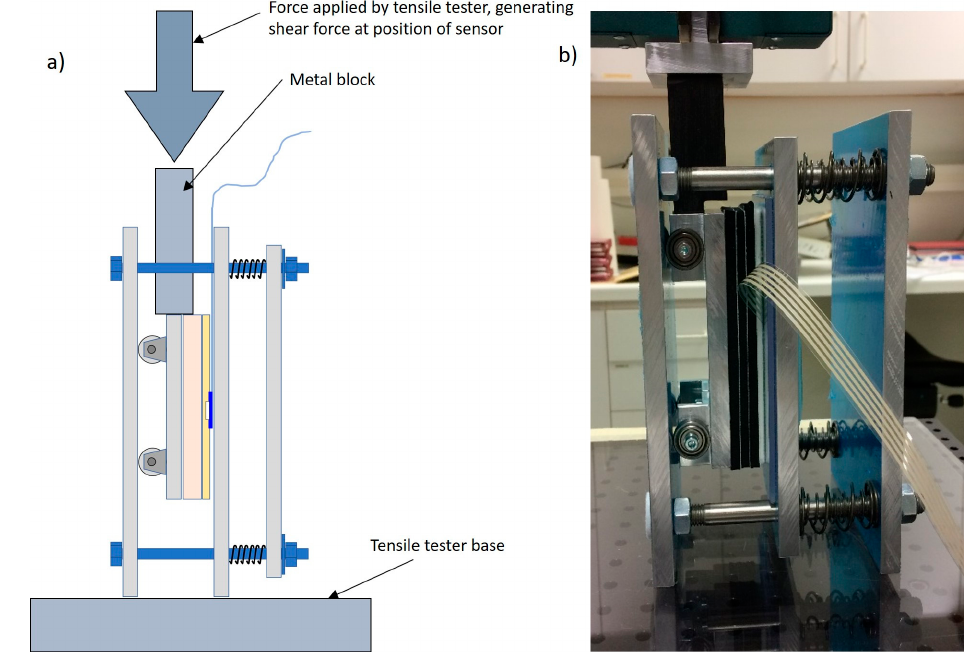
Figure 27. A principle drawing ( a ) and a photo ( b ) showing the shear sensor test rig with the ten- sile tester during testing.